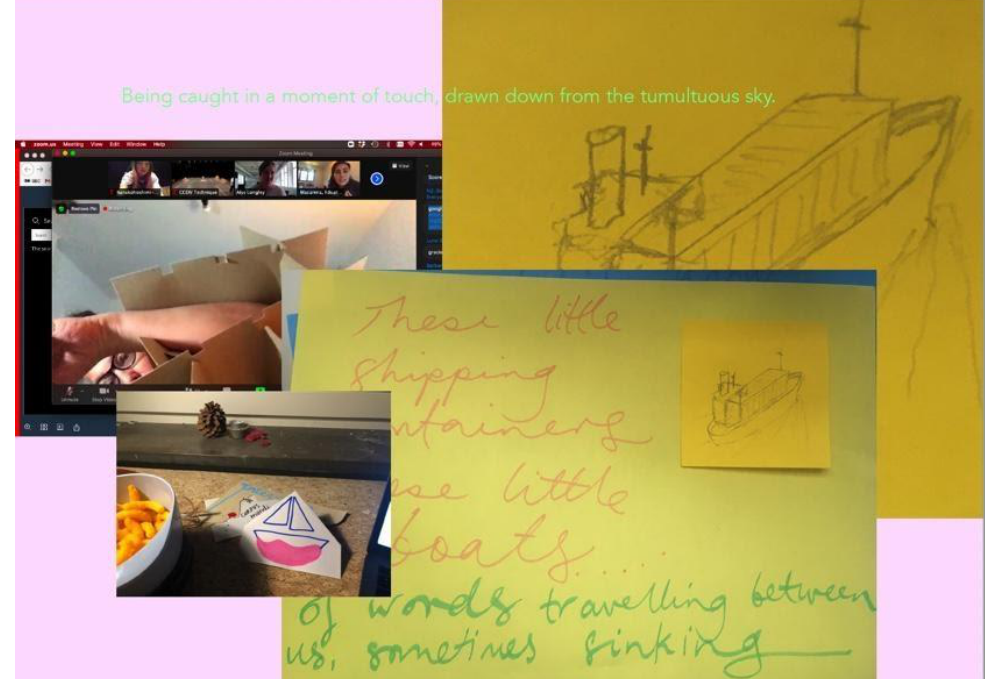
Figure 11 : Page from Language is An Intangible Bridge Workshop Workbook, designed by pavleheidler and Alys Longley, with contributions by participants in the Language is An Intangible Bridge Workshop, hosted by CCOV